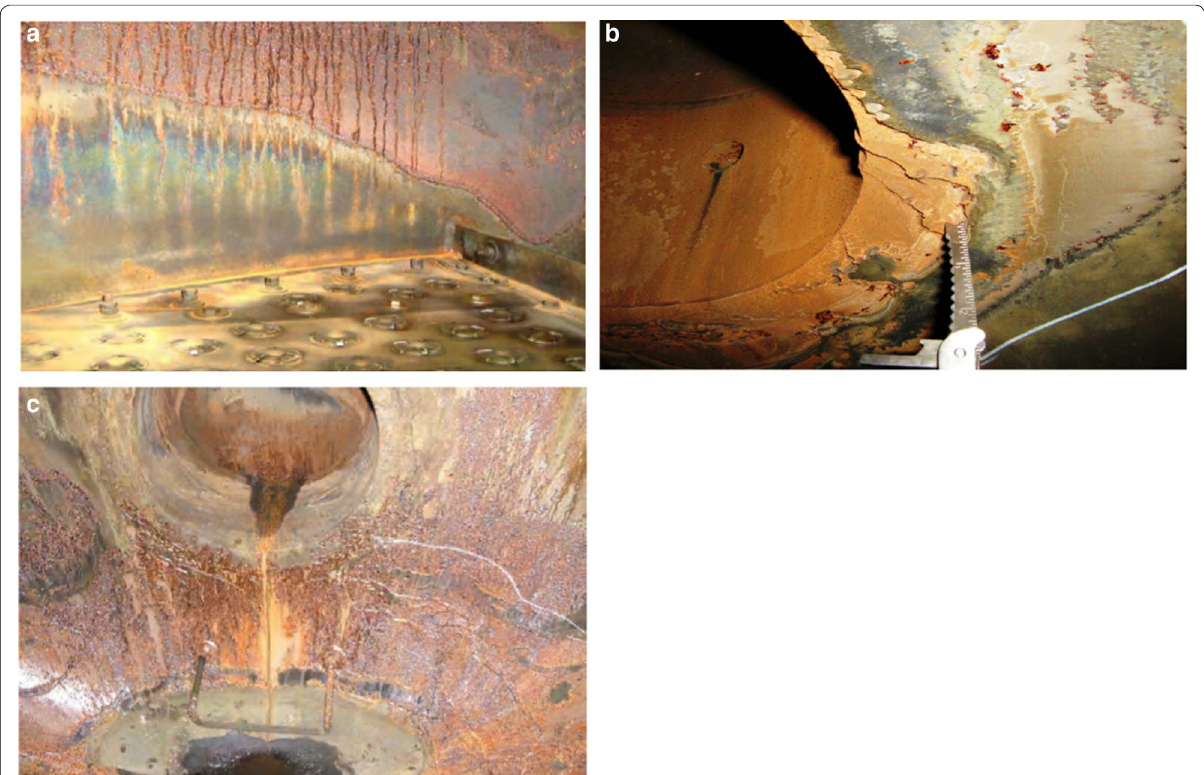
Fig. 11 Corrosion a in the vapor phase above the normal liquid level through the regenerator tower between chimney tray and tray #7; b in vapor side of reboiler around the vapor line nozzles; c through the reboiler shell of the regenerator behind the baffle